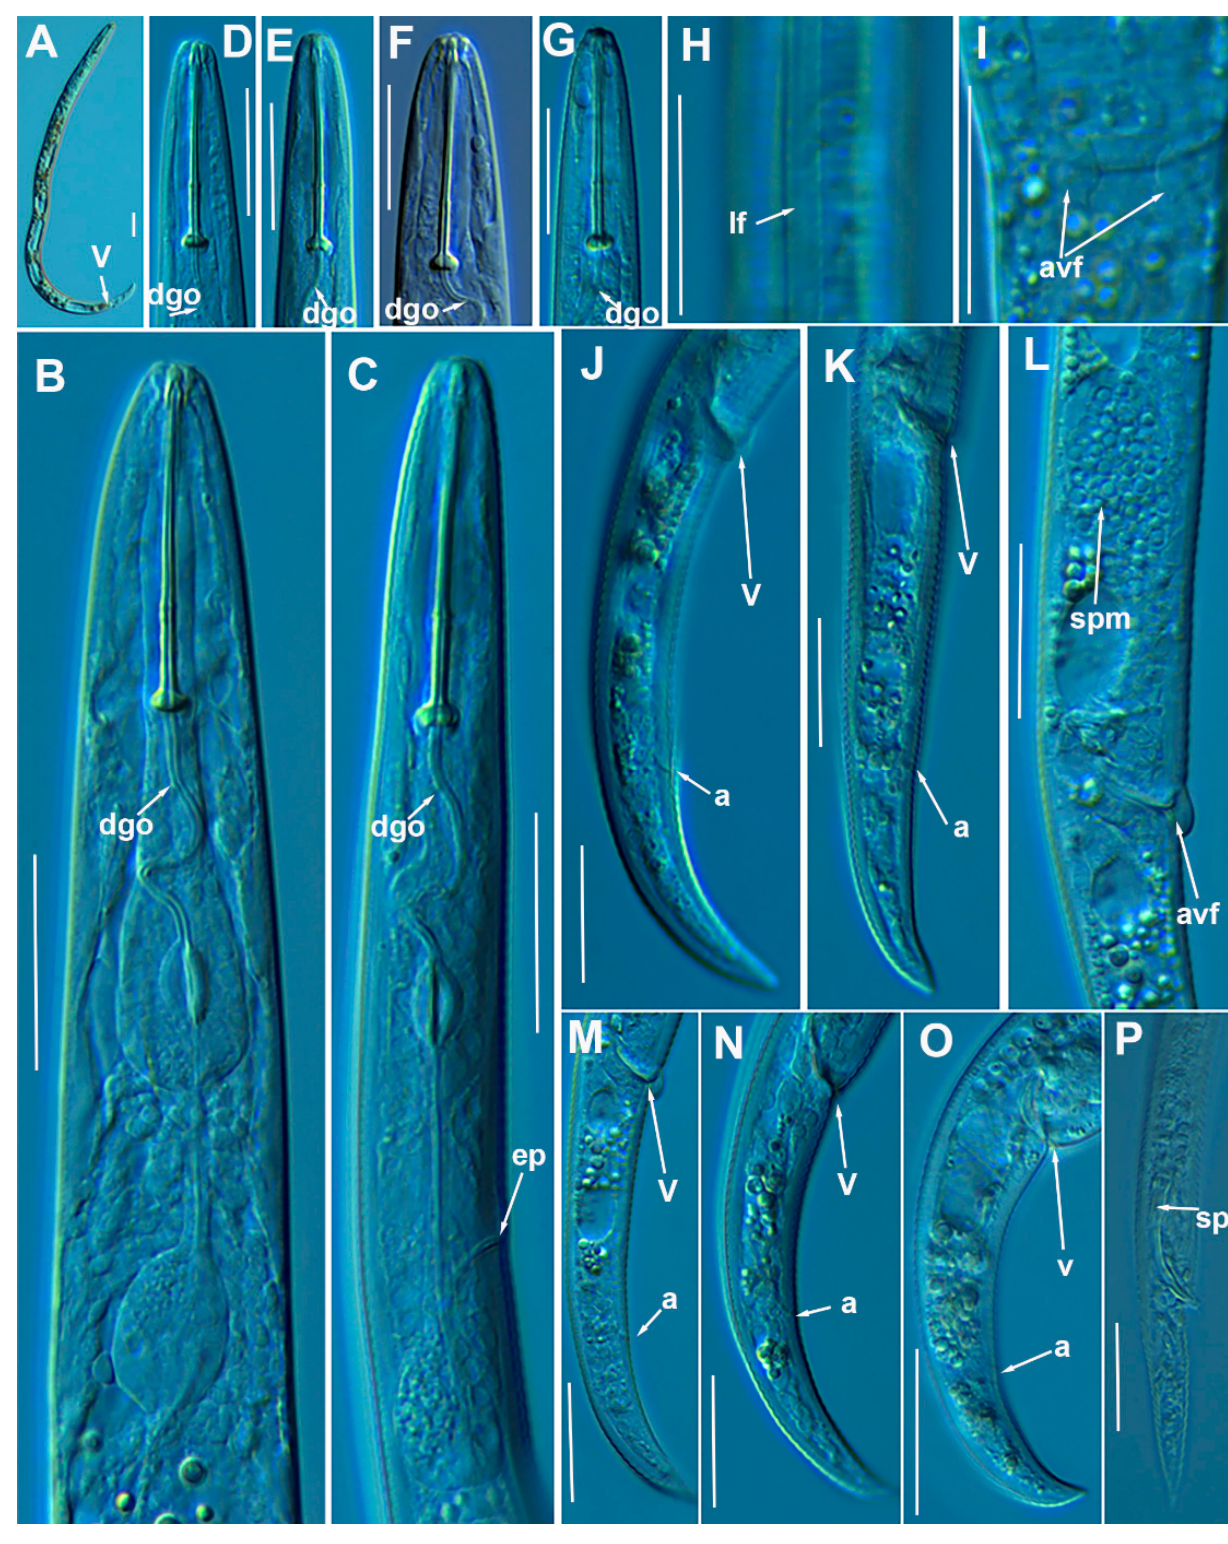
Figure 18. Light photomicrographs of Paratylenchus tenuicaudatus Wu, 1961. ( A ): Entire female with vulva arrowed; ( B , C ): Female pharyngeal region; ( D – G ): Female lip region; ( H ): Detail of female lateral field at mid-body (arrowed); ( I ): Detail of vulva showing a frontal view of advulval flap (arrowed); ( J – O ): Female posterior region showing vulva and anus (arrowed); ( P ): Male tail with spicules arrowed. Scale bars ( A – P = 20 µ m). (Abbreviations: a = anus; avf = advulval flap; dgo = pharyngeal dorsal gland orifice; ep = excretory pore; lf = lateral field; spm = spermatheca; sp= spicules; V = vulva).